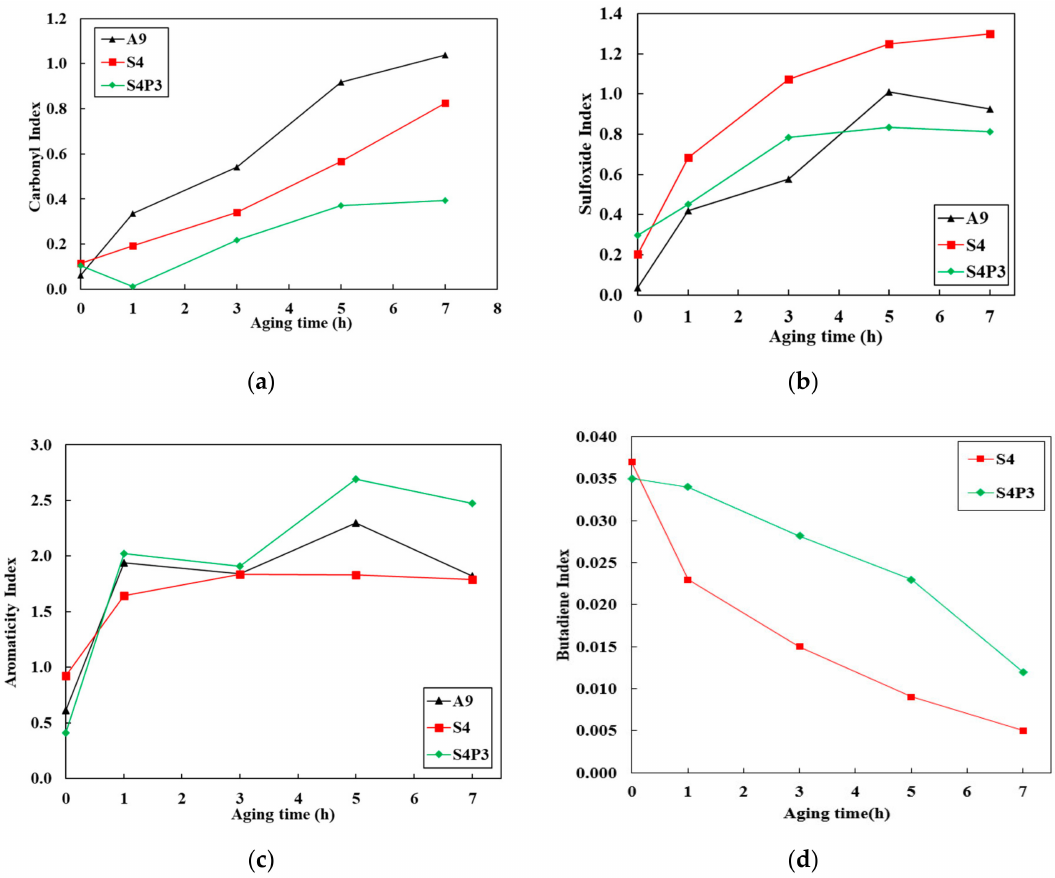
Figure 8. Structure index evolution at di ff erent aging times. ( a ) Carbonyl index; ( b ) sulfoxide index; ( c ) aromaticity index; ( b ) butadiene